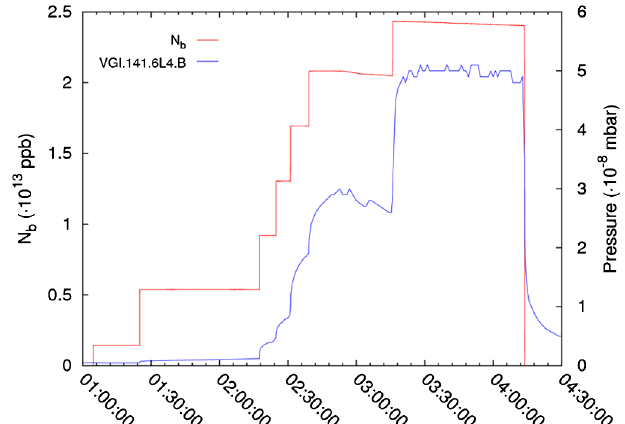
FIG. 3. Beam intensity and pressure at the gauge VGI.141.6L4.B during the first experiment on 6 April 2011. Every step in the beam intensity (red curve) indicates the injection of a new batch.